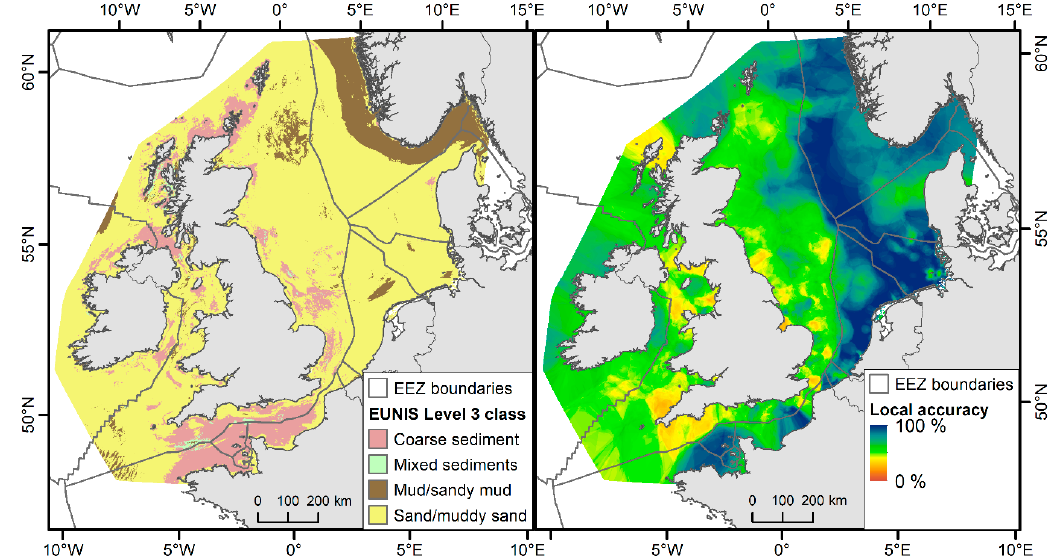
Figure 7. Predicted sediment class based on EUNIS Level 3 class definitions and the spatial distribution of accuracy.